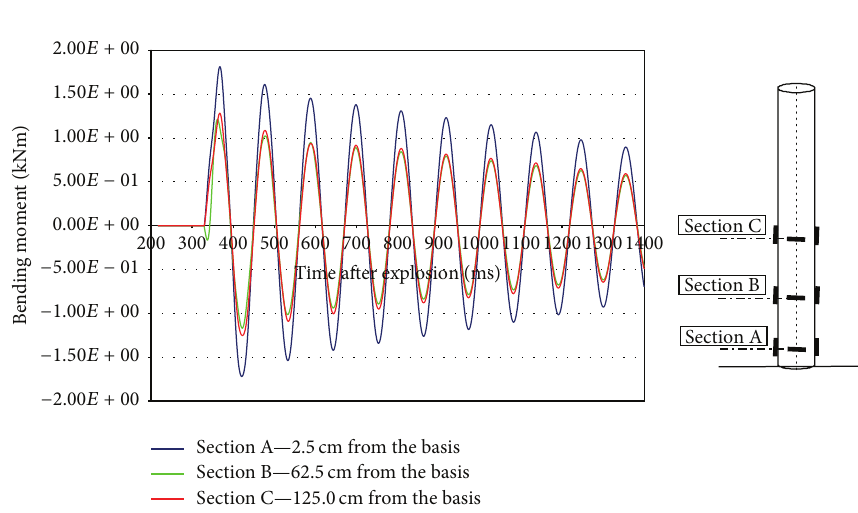
Figure 3: Bending histories at instrumented cross sections, first test.